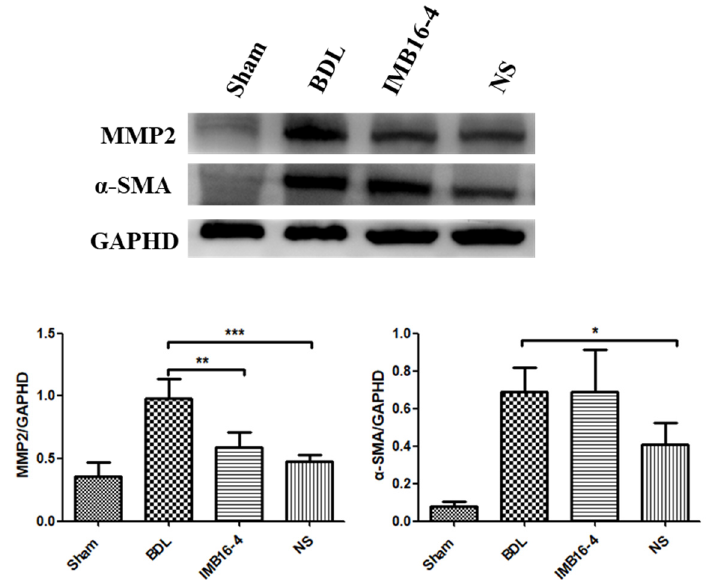
Figure 7. Western blot analysis and semi-quantitation of α -SMA and MMP2 protein levels in liver tissue. The values are expressed as the mean ± SD of four times independent experiments. * p < 0.05, ** p < 0.01 and *** p < 0.001 significantly different from the BDL group.